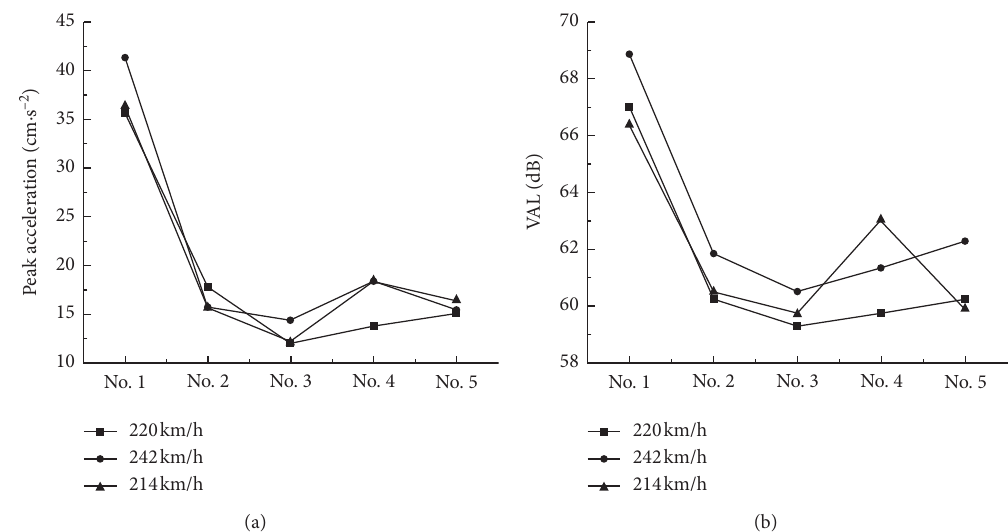
Figure 7: Peak acceleration in X direction and VAL at five test points as a function of train speed. (a) Peak acceleration. (b) Vibration acceleration level.